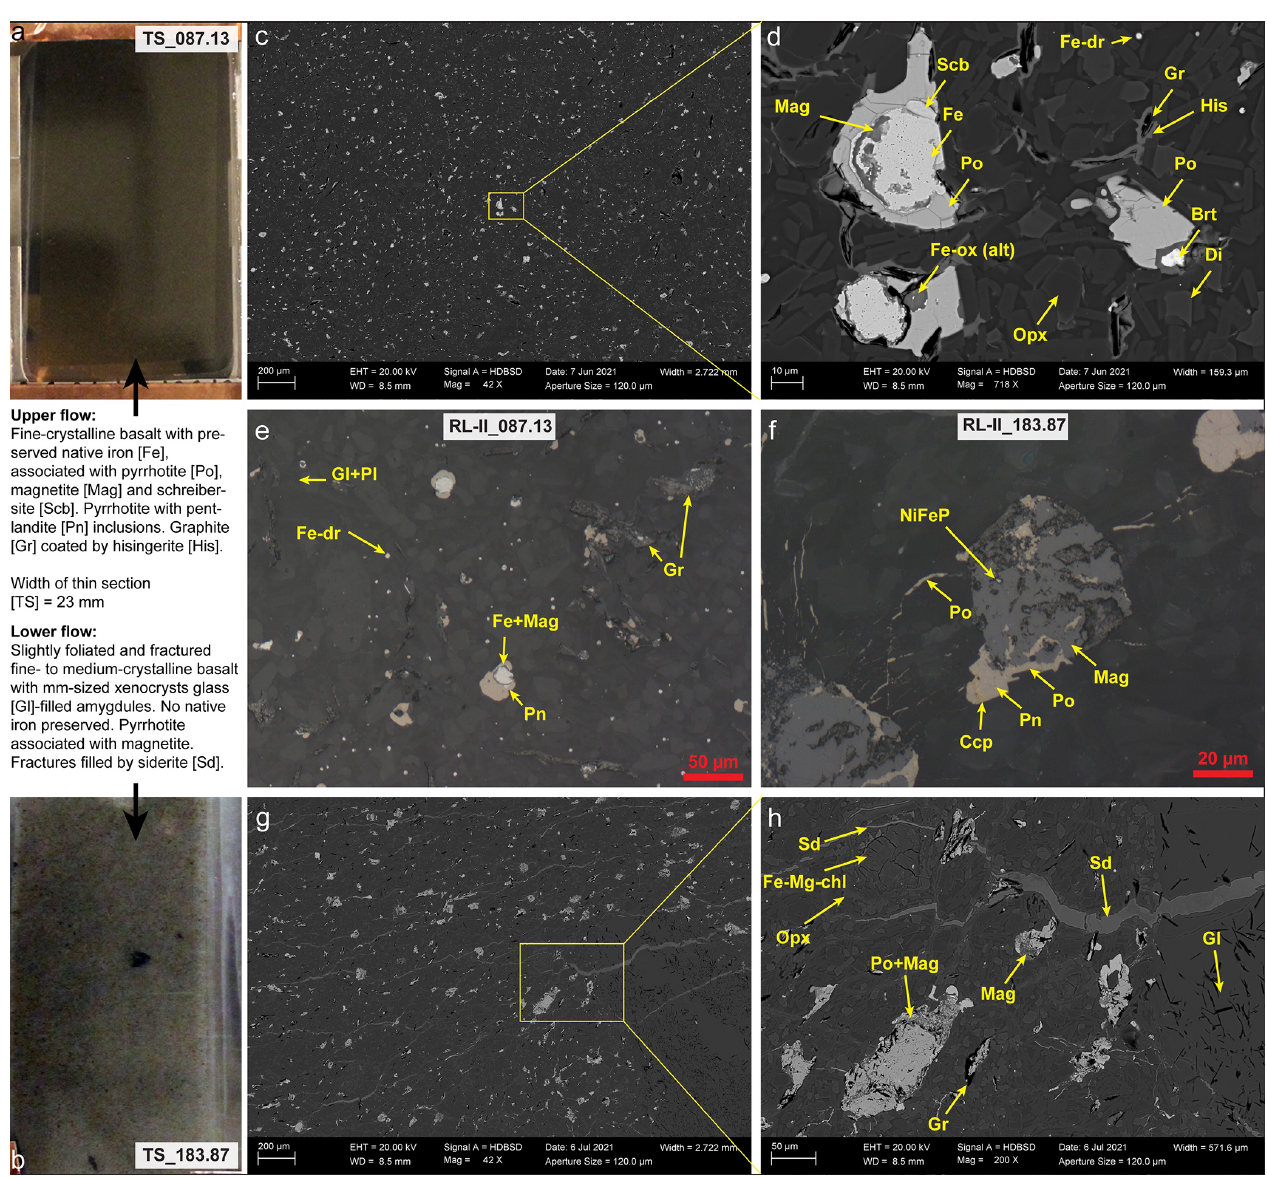
Figure 11. (a) Photograph of a polished thin section of a fine crystalline basalt sample from the upper flow (87.13m core depth). (b) Photo- graph of a polished thin section of a fine to medium crystalline basalt sample from the lower flow (183.87m core depth). (c–d) Backscatter electron micrographs (BSE) of sample at 87.13m depth with preserved native iron (Fe) blebs and Fe droplets (Fe-dr) and minor magnetite (Mag) and Fe oxide (Fe-ox) in association with pyrrhotite (Po), schreibersite (Scb), graphite (Gr) and hisingerite (His). Brt: barite, Di: diop- side, Opx: orthopyroxene. (e) Reflected light micrograph of the same sample with larger native Fe blebs with a magnetite rim and association with pyrrhotite and smaller micrometre-sized Fe droplets dispersed in matrix. (f) Reflected light micrograph of sample at 183.87m core depth with no preserved native Fe, but magnetite in association with pyrrhotite. Pyrrhotite with pentlandite (Pn) flames and chalcopyrite inclusions. (g–h) Backscatter electron micrographs (BSE) of the same sample with pyrrhotite in association with magnetite and graphite and siderite-filled (Sd-filled) fractures that also cross-cut a glass-filled (Gl-filled) amygdule. Fe–Mg–chl: